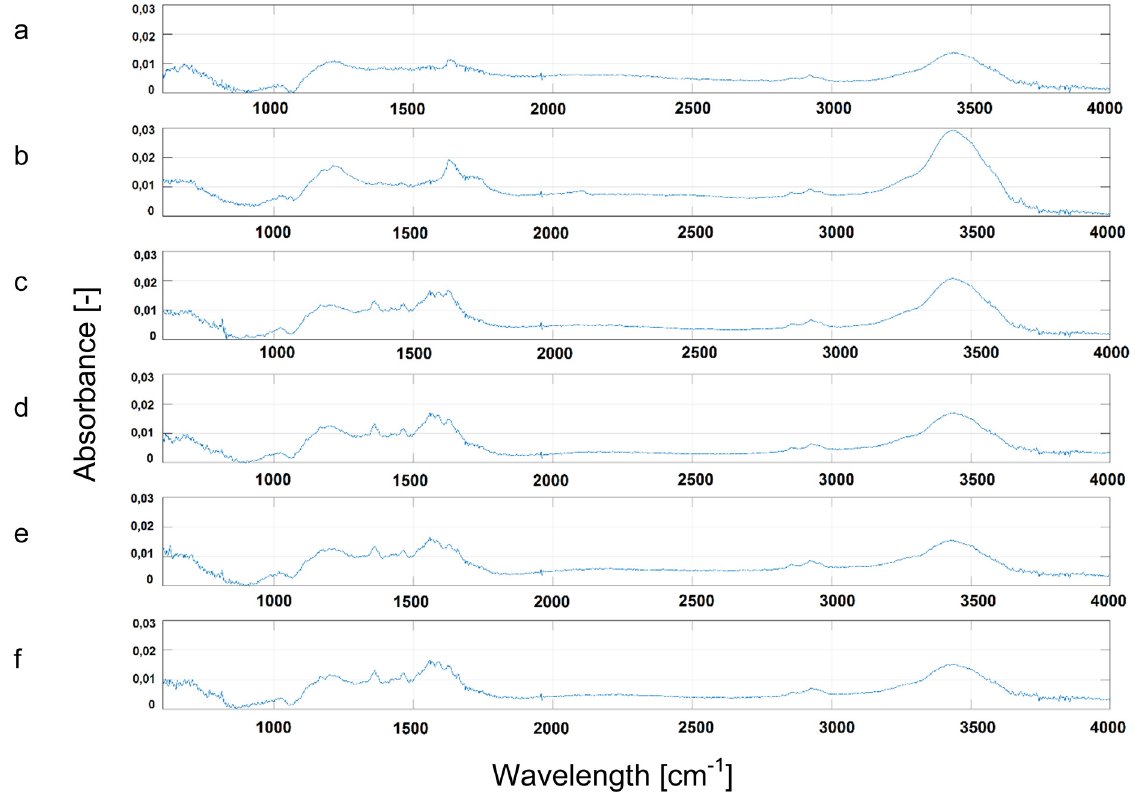
Figure 7: FTIR spectra for CNTs after each stage of chemical modi fi cation: ( a ) unmodi fi ed CNTs after puri fi cation processes; ( b ) modi fi ed carbon CNTs after oxidation reaction; ( c ) modi fi ed CNTs after amidation reaction with NH 2 – ( CH 2 ) 4 – NH 2 ; ( d ) modi fi ed CNTs after acylation with 4 -( 1 - pyrinyl )- butanoic acid; ( e ) modi fi ed CNTs after acylation with 5 ( 6 )- carboxy fl uorescein; ( f ) modi fi ed CNTs after acylation with rhodamine